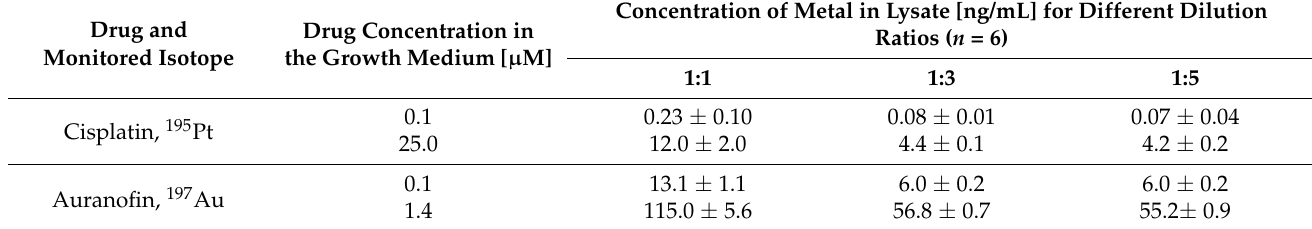
Table 1. Concentrations of Pt and Au in lysates established for different dilution ratios. Drug and Drug Concentration Monitored Isotope